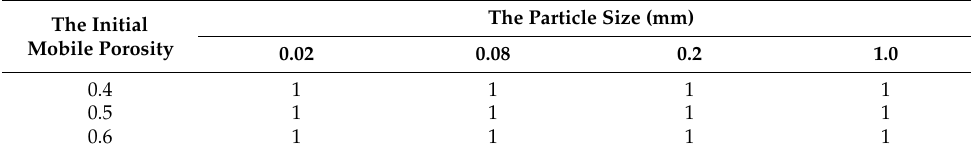
Table 1. Summary of Working Conditions in DIW.